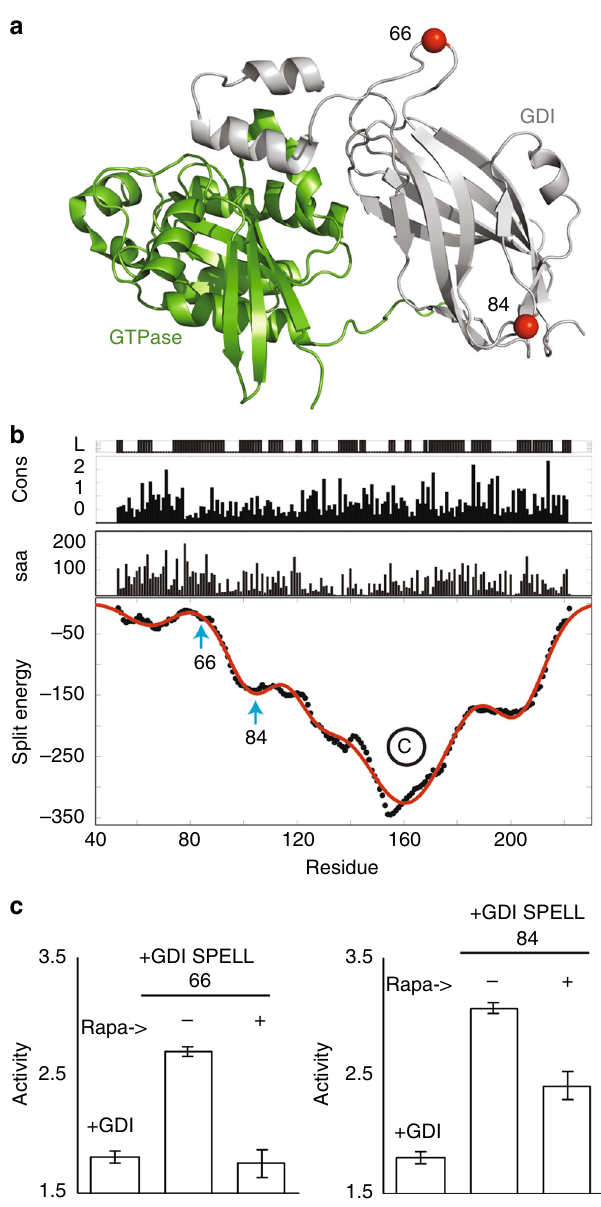
Fig. 3 GDI SPELL. a The structure of RhoGDI bound to the GTPase Cdc42. b The SPELL algorithm indicated residue 66 as a split site. c The inhibitory activity of GDI SPELL (split at 66) was activated by rapamycin, whereas another design (split at 84) split at a small well did not display full activity with rapamycin. Error bars represent ± s.e.m. ( n = 3) from